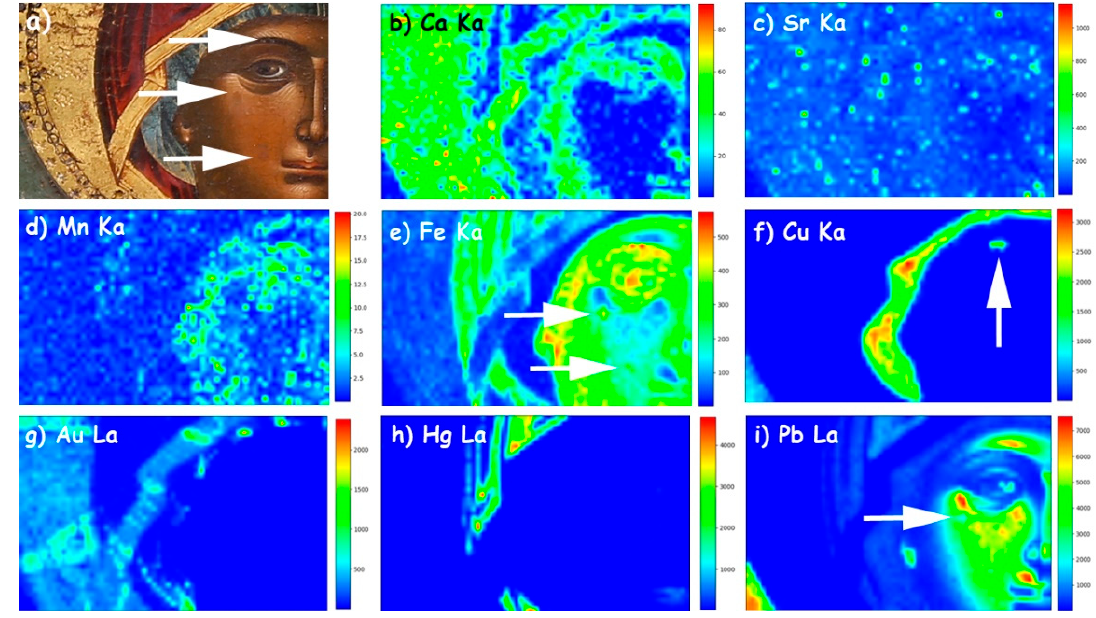
Figure 3. ( a ) Macro photograph of the scanned area; ( b ) Scanning XRF image of the Ca K α transition intensity; ( c ) Sr K α map; ( d ) Mn K α map; ( e ) Fe K α map; ( f ) Cu K α map; ( g ) Au L α map; ( h ) Hg L α map; and ( i ) Pb L α map. Arrows indicate areas of later interventions.